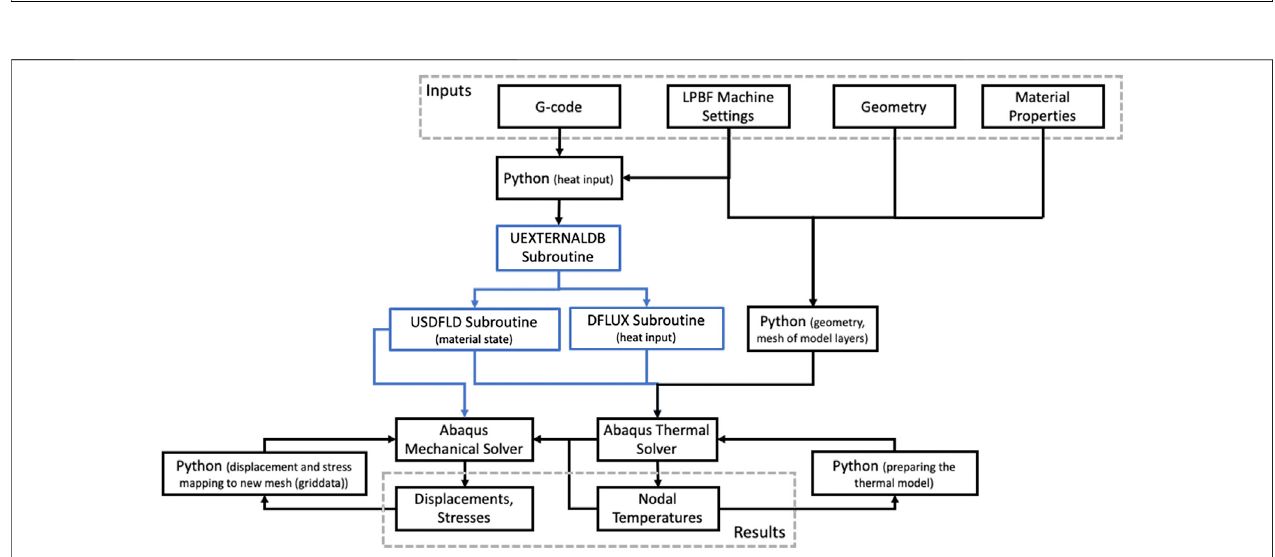
FIGURE 4 | Flowchart of the computational framework including subroutines (blue) and interactions with customized Python programs.